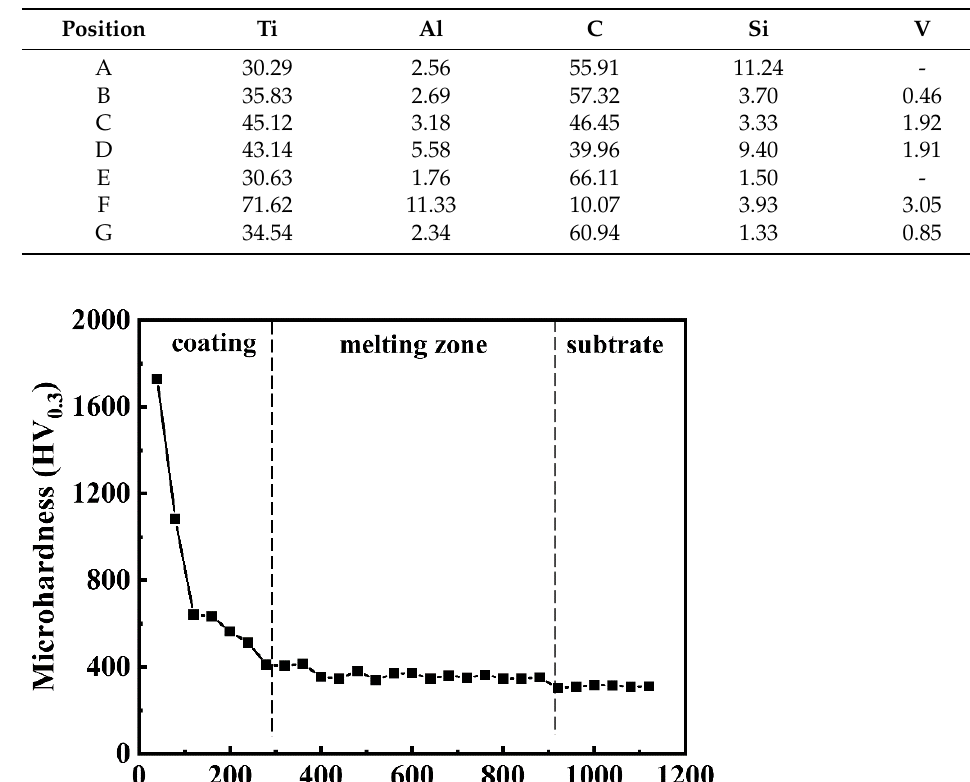
Figure 7. X-ray diffraction ( XRD) spectrum of the composite layer. Table 3. Results of Energy Dispersive Spectrometer (EDS) in different regions of composite layer (at.%).